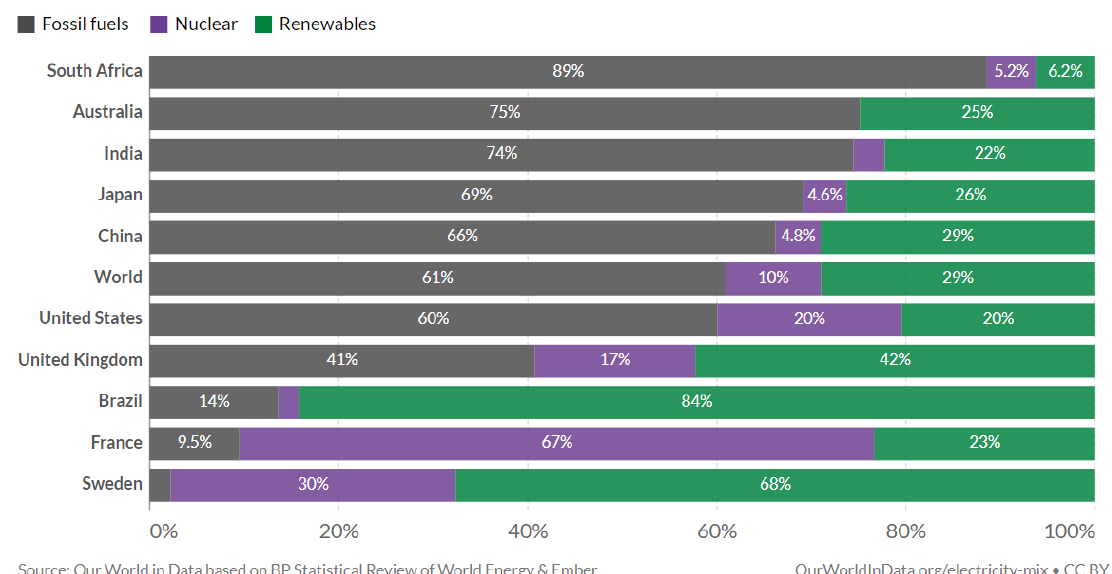
Figure 5. Per capita electricity consumption by source, 2020 (Source: https://ourworldindata.org/electricity-mix, last accessed on 12 December 2021).